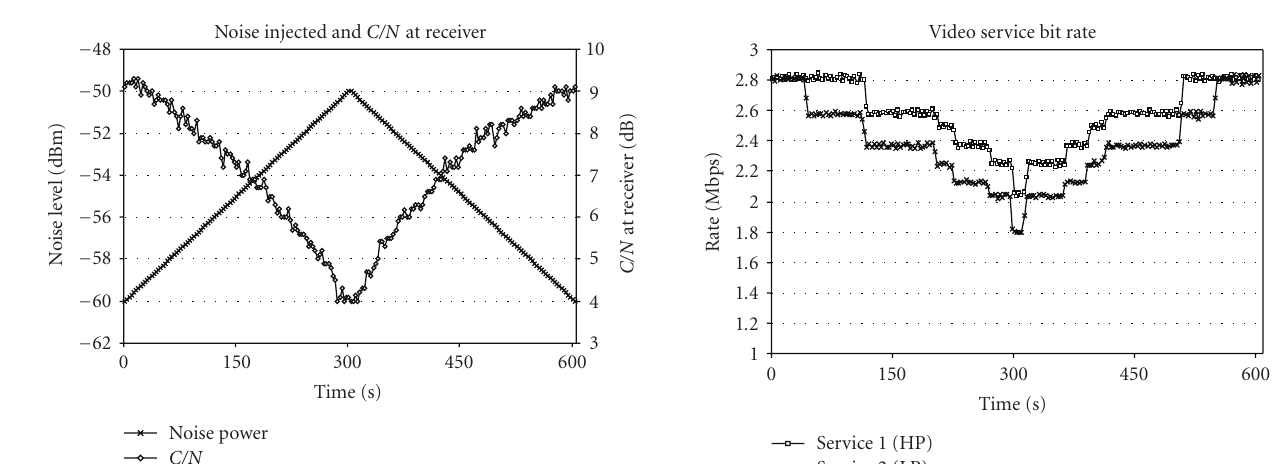
Figure 7: Adaptation of TV service rates as a result of C/N